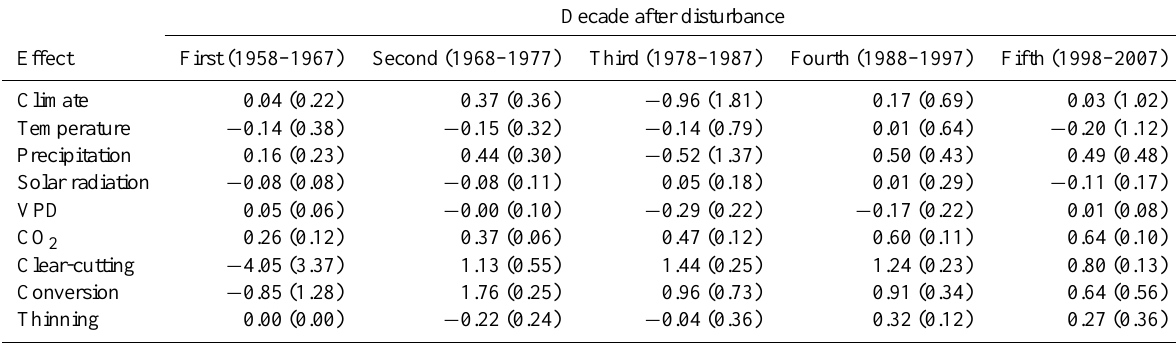
Table 3. Average effects of climate, air temperature, precipitation, solar radiation, vapor-pressure deficit (VPD), CO 2 , clear-cutting, conver- sion, and thinning on net ecosystem production at the Tomakomai site for each decade after the disturbance in 1958. Positive values represent enhancement effects on each flux, and negative values indicate the opposite. Units are tCha − 1 year − 1 . Values in parentheses are standard